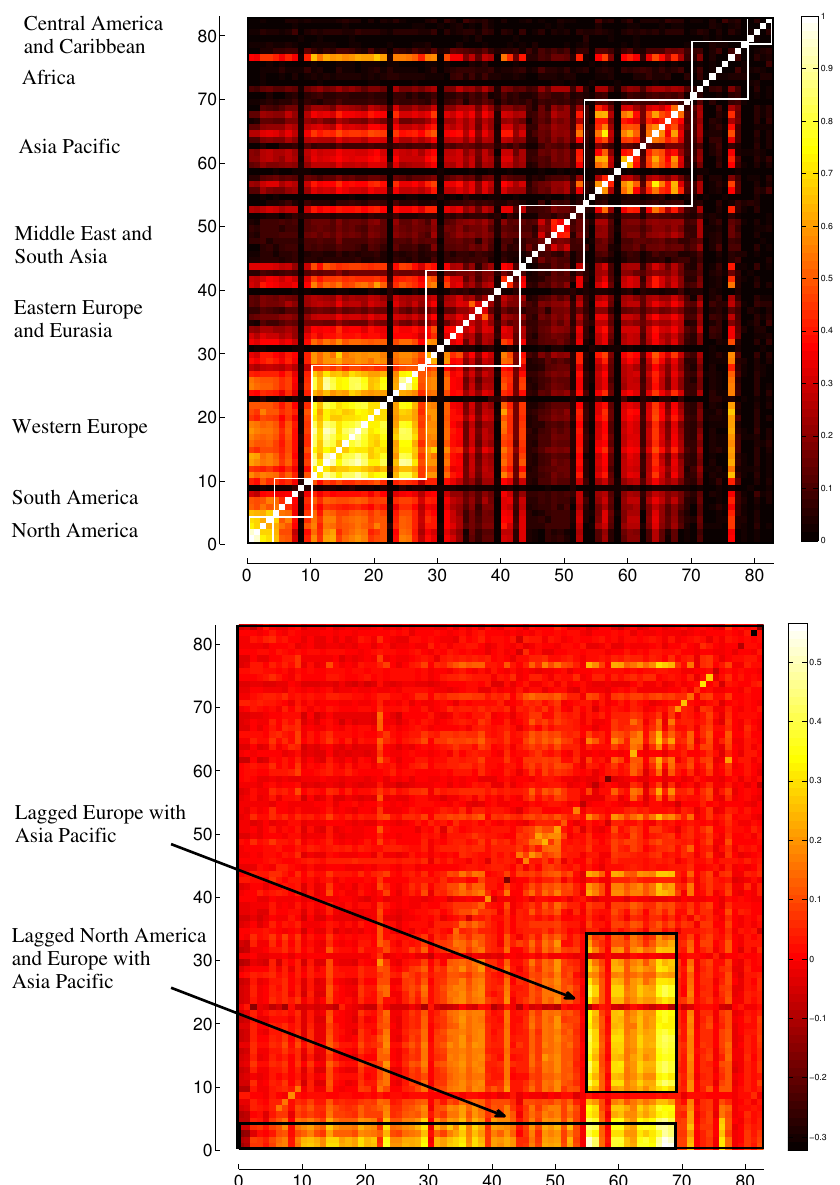
Figure 2. Heat maps of the correlation submatrices for original × original indices and for lagged × original indices,